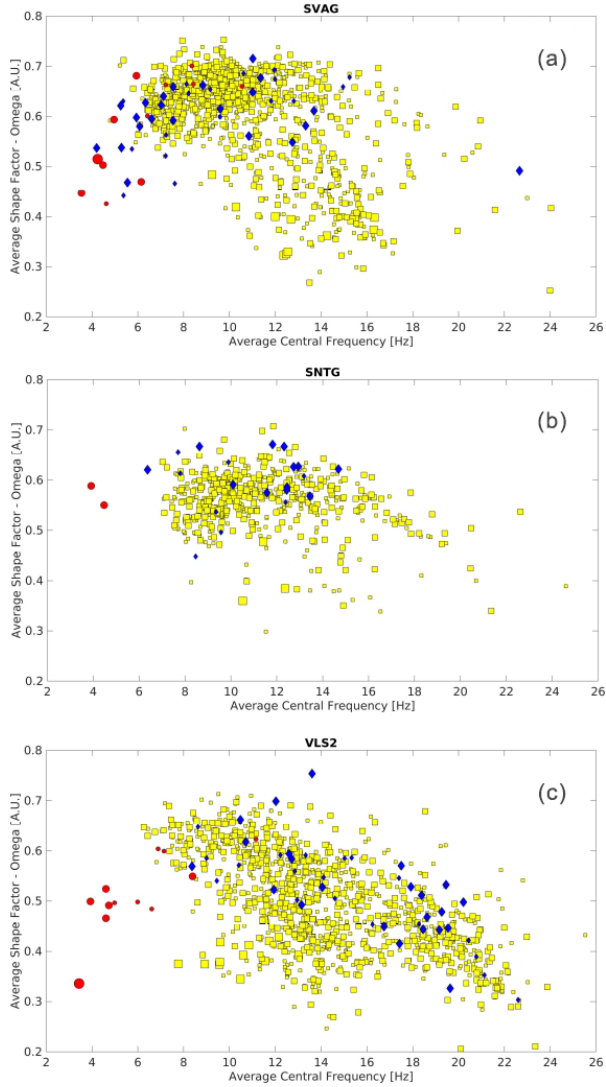
Figure 5. Average shape factor vs central frequency evaluated for SVAG (a) , SNTG (b) and VLS2 (c) stations located on the northern sector of Mt. Vesuvius (see Fig. 1). LF events, unclassified events and VT earthquakes are shown with red circles, blue diamonds and yellow squares, respectively. The symbol size indicates the maxi- mum amplitude of the observed signals. The illustrated results are obtained by averaging on the three components of